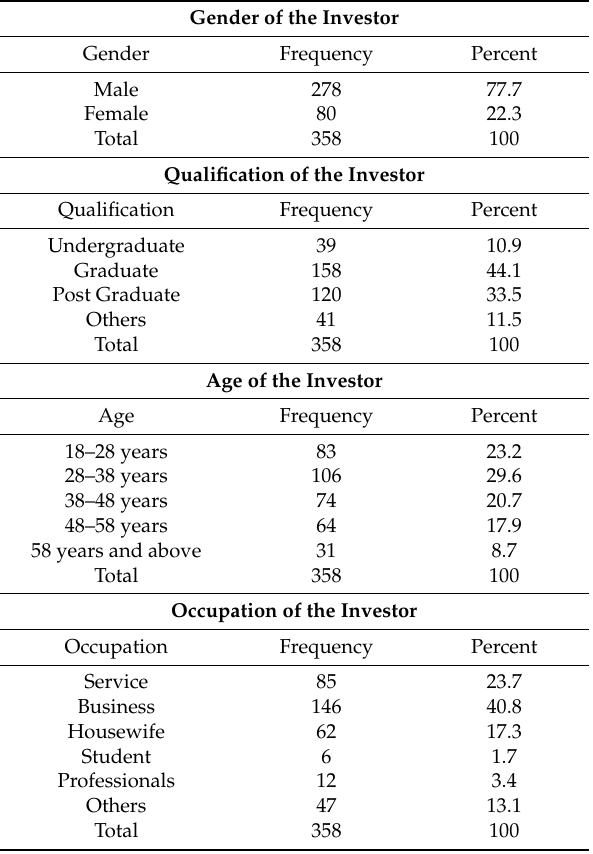
Table 2. Demographic and socio-economic profile of the